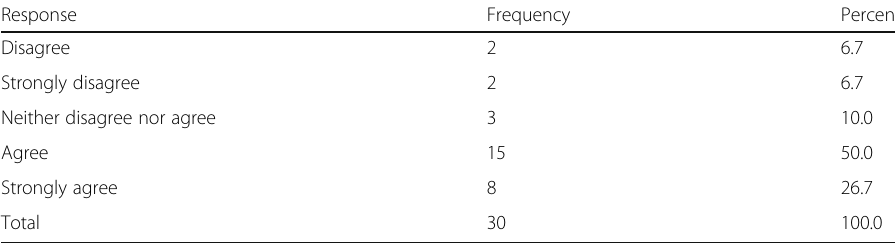
Table 8 Privatization of container handling processes